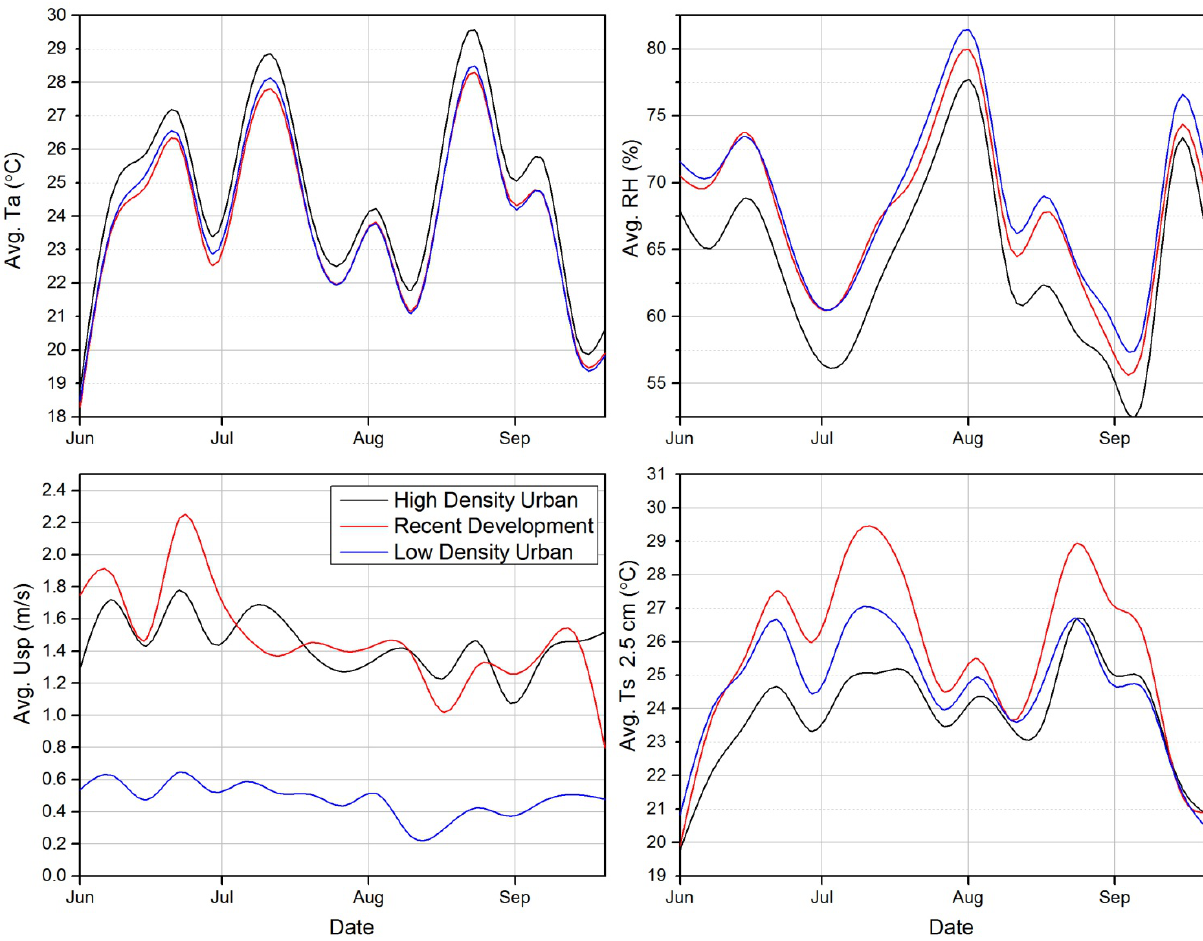
Figure 8. Average climate results at low density urban, recent development, and high density urban gradient monitoring sites from 2 June 2013 to 28 September 2013, Columbia, Missouri, USA. Ta = air temperature, RH = relative humidity, Usp = wind speed, Ts = soil